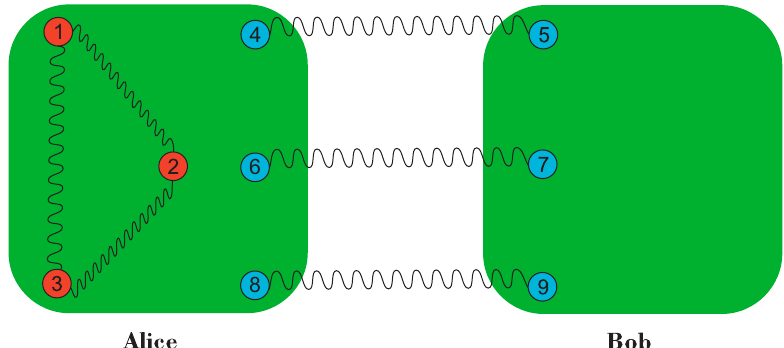
Figure 7. Scheme to teleport a GHZ state. In this scheme, three EPR states are used as the quantum channel and EPR measurements are taken on qubits 1, 4 and 2, 6 and 3, 8, respectively. At the end, the qubits 5, 7, 9 hold in a GHZ